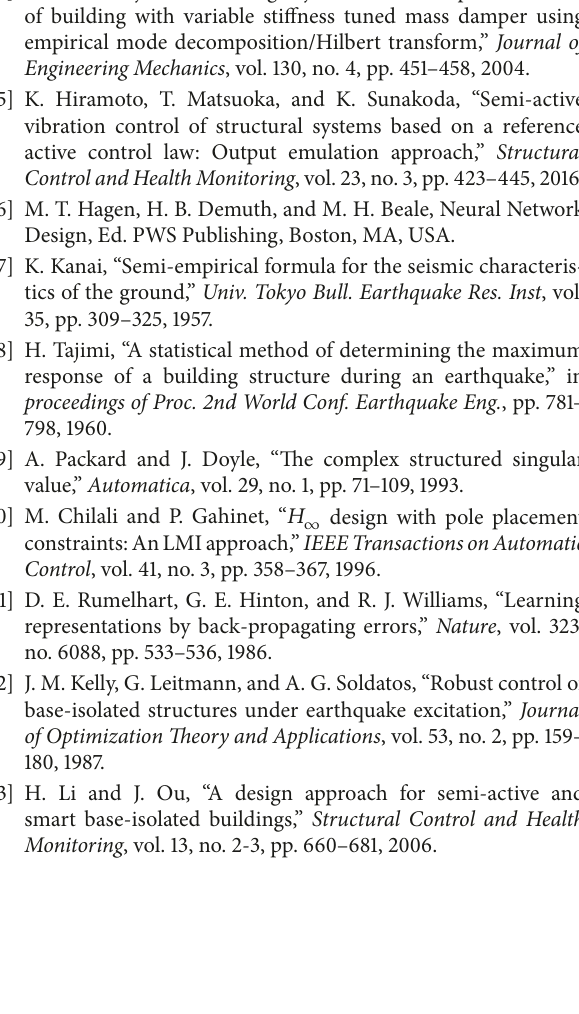
against earthquake disturbances whose time and